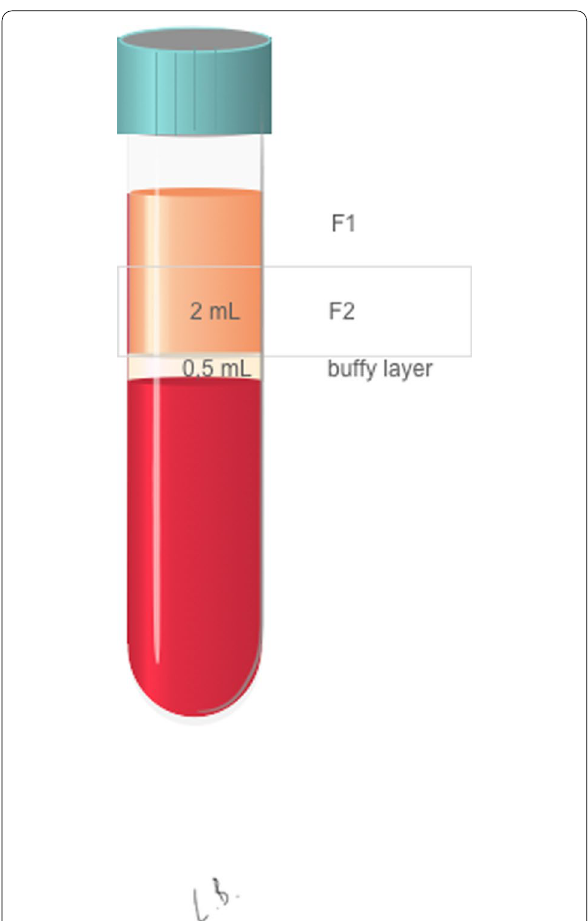
Fig. 2 F1: fraction one, consisting in the platelet‑poor plasma. F2: fraction two, the 2 mL immediately above the buffy layer, where the platelet concentration is